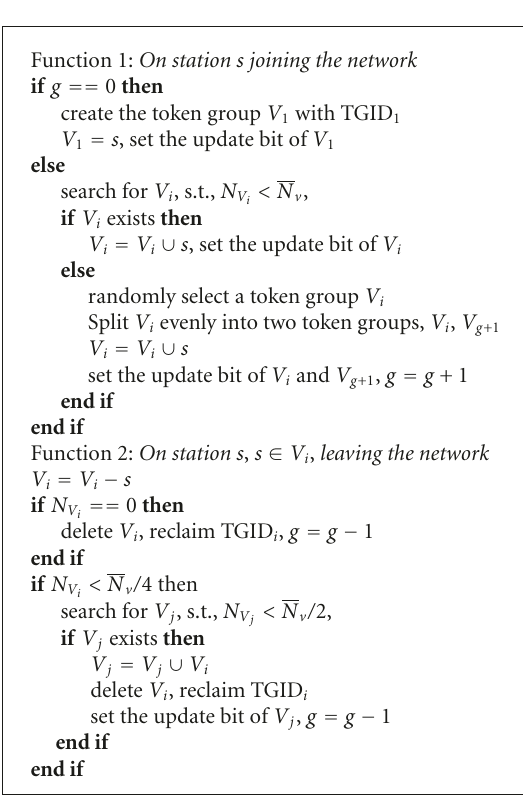
Algorithm 1: Group membership management